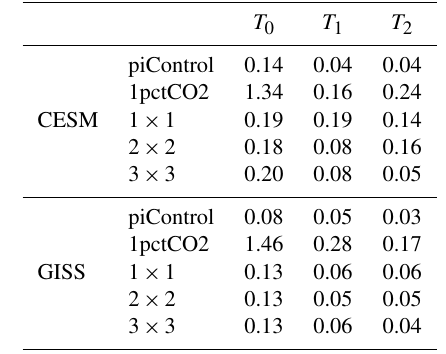
Table 2. Root-mean-square (RMS) differences in T 0 , T 1 , and T 2 (see Sect. 2 for definitions) for all of the simulations in the 3 × 3 design case. All units are in ◦ C. Values are calculated over the entire 70-year simulation as the RMS of interannual deviations from the preindustrial control (piControl)